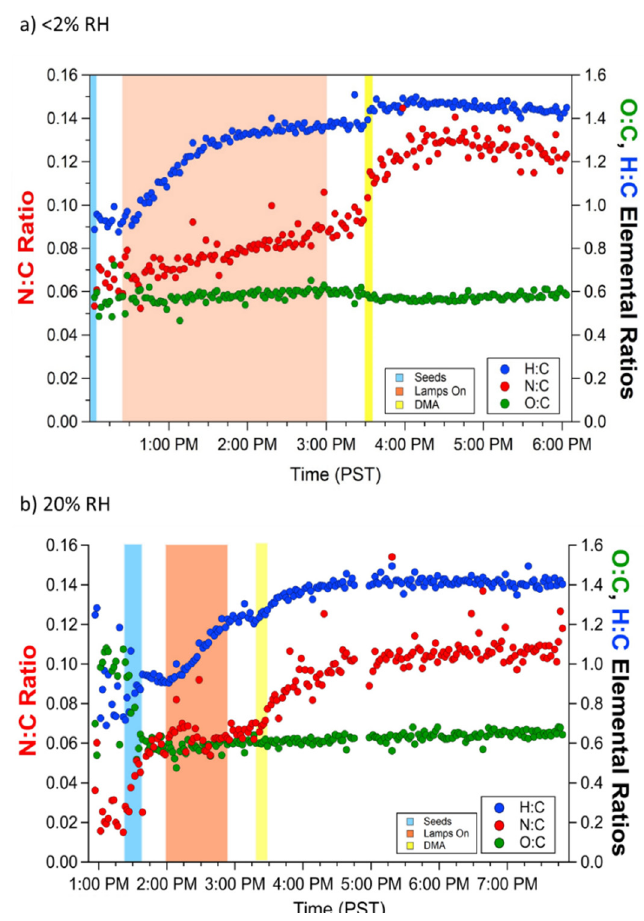
Figure 4. TOL/OH SOA exposed to DMA (yellow region) at ( a ) <2% and ( b ) 20% RH.